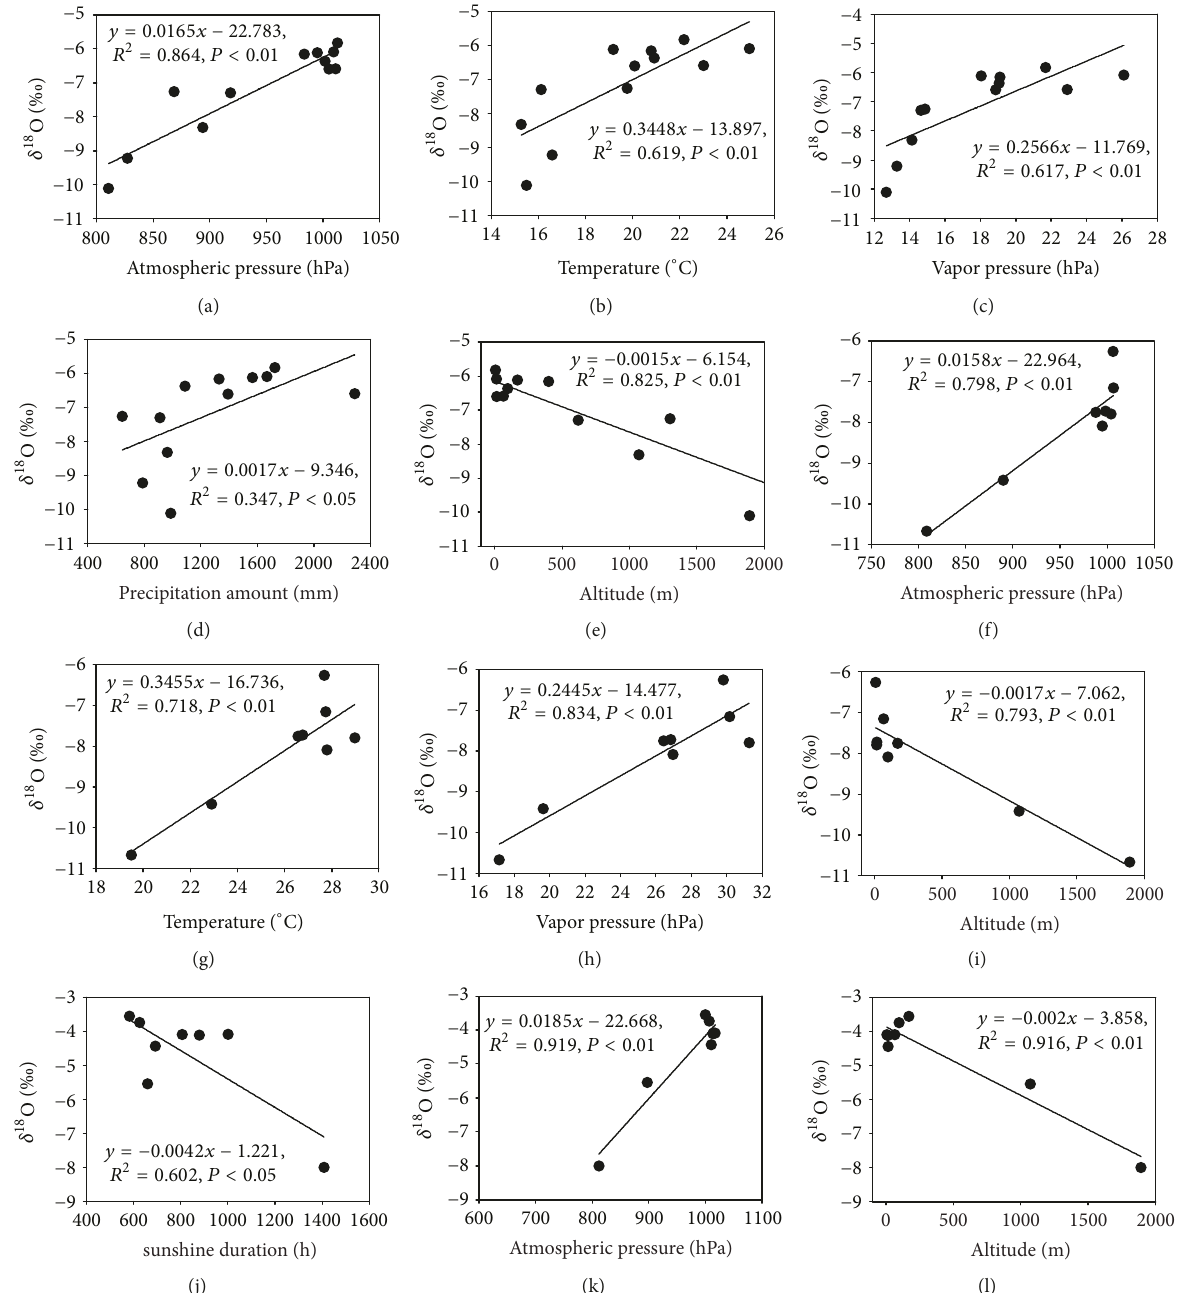
Figure 6: Correlations of mean weighted precipitation 𝛿 18 O values for stations with meteorological and geographical factors which are at 𝑃 value < 0.05 or 0.01. Note: (a), (b), (c), (d), and (e) represent the mean annual values; (f), (g), (h), and (i) represent the mean values for the summer monsoon period; (j), (k), and (l) represent the mean values for the nonsummer monsoon period.